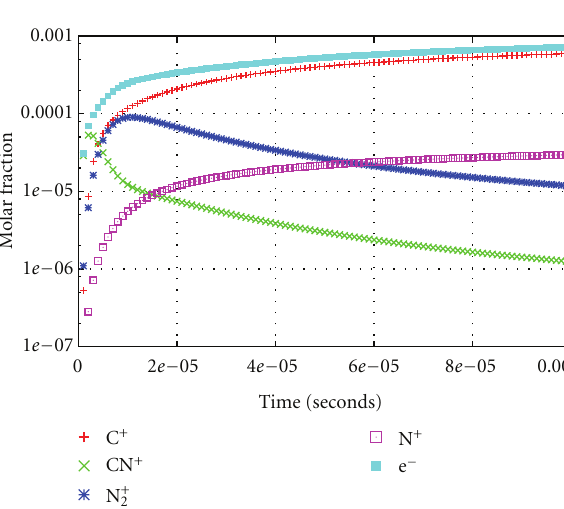
Figure 4: Neutrals-reduced model.